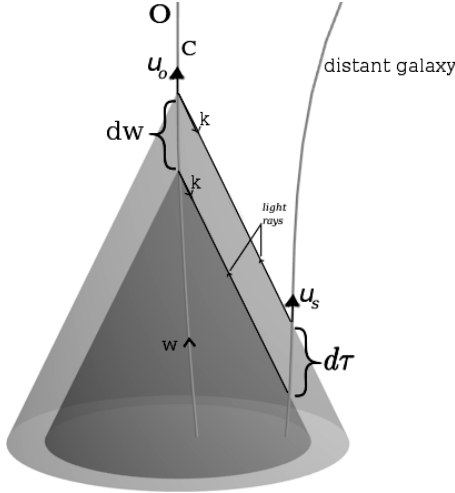
Figure 2. A time interval d τ at the observed galaxy is measured as a time interval dw by the